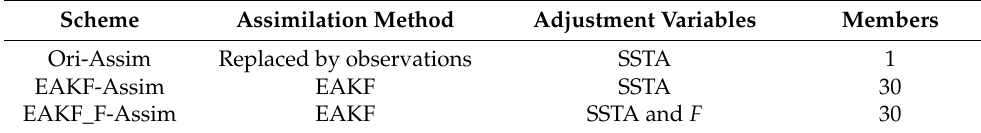
Table 1. Settings of the assimilation